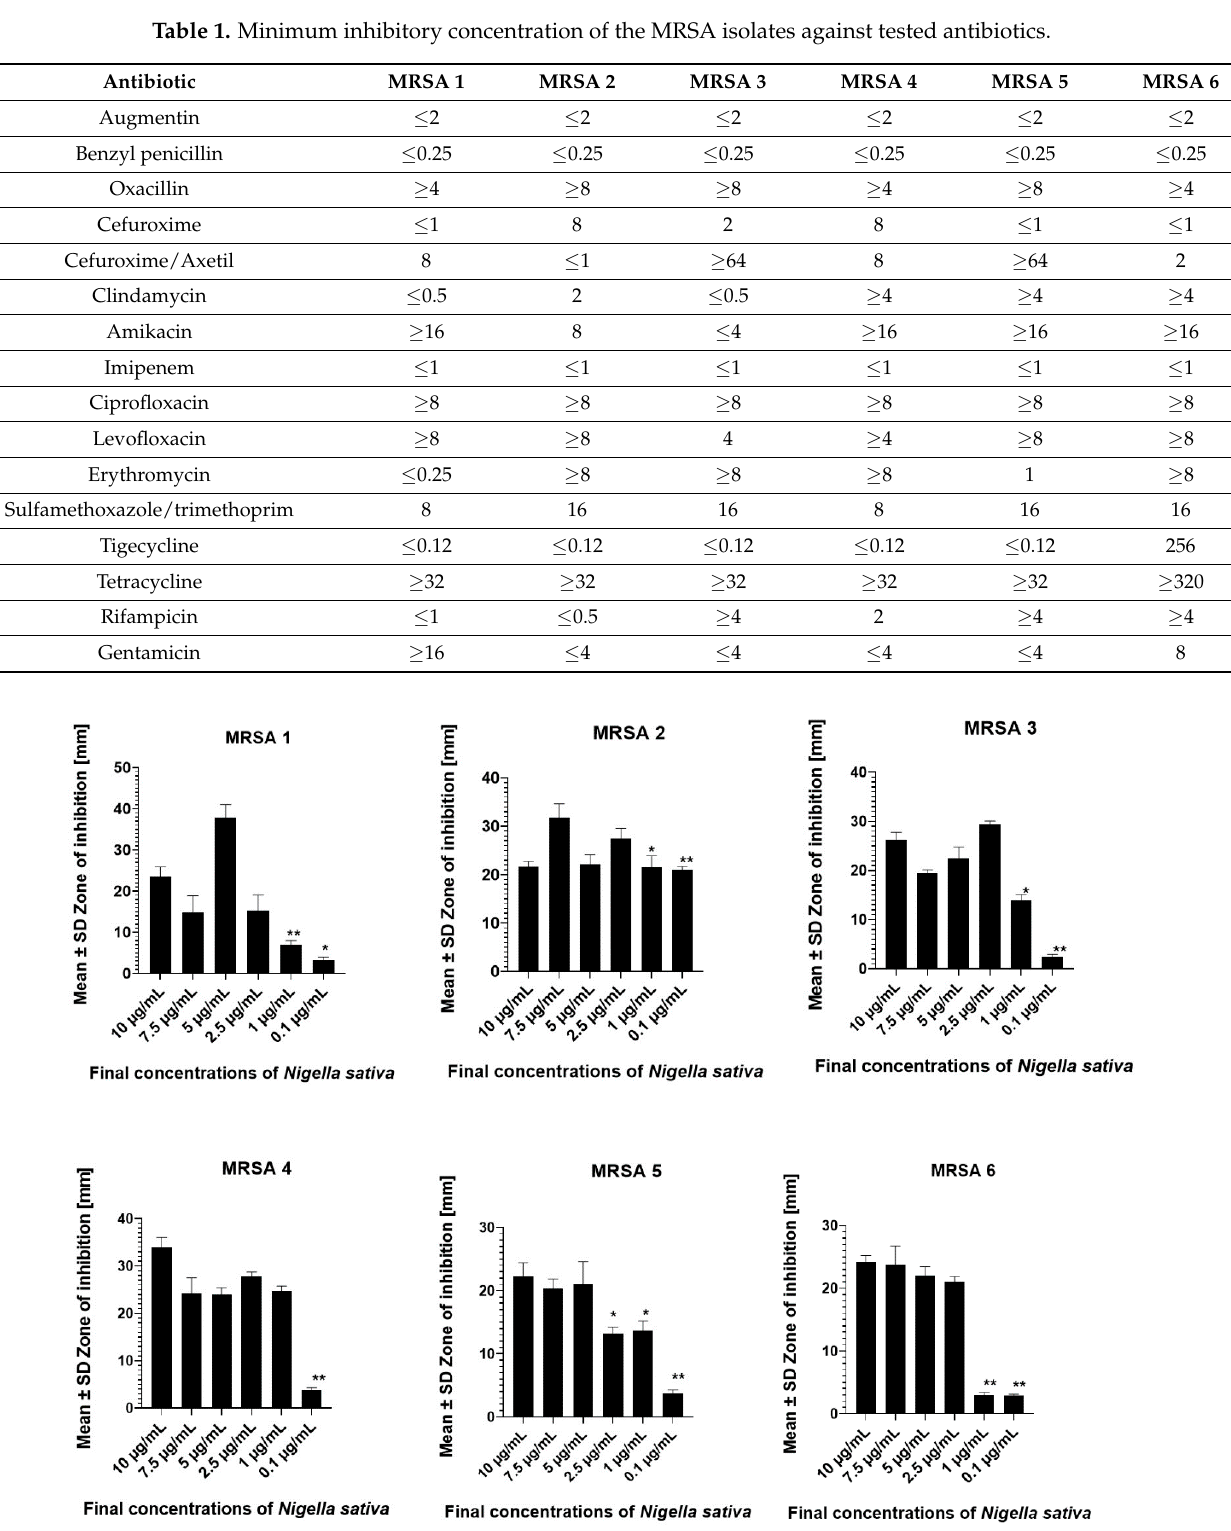
Figure 2. Showing the zones of mean ± SD inhibition of methicillin-resistant Staphylococcus aureus (MRSA), MRSA 1–6 bacterial isolates against Nigella sativa (NS) dilutions. Comparison of 10 µg/mL and other concentrations. * p -value: 0.034; ** p -value: 0.0001.